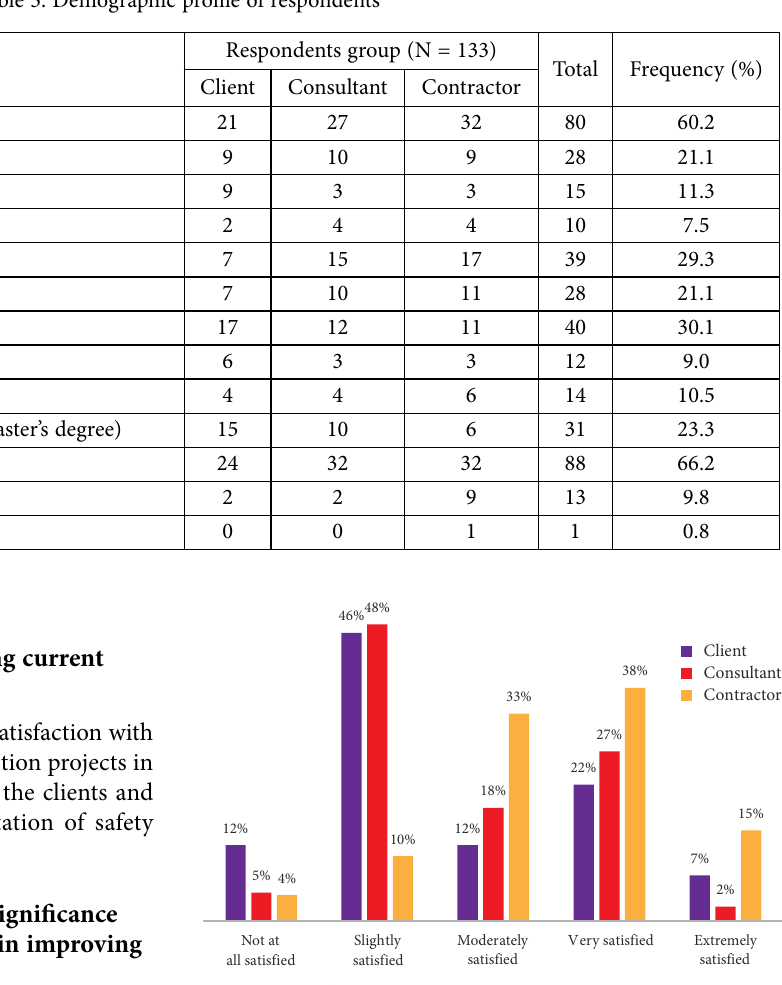
Table 3. Demographic profile of respondents